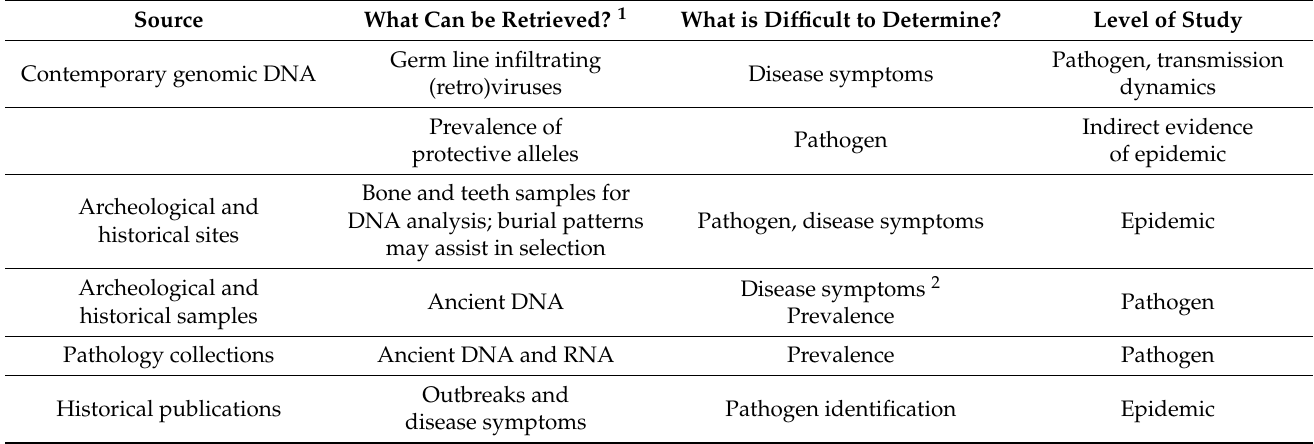
Table 1. Sources available for the study of ancient pathogens and historical